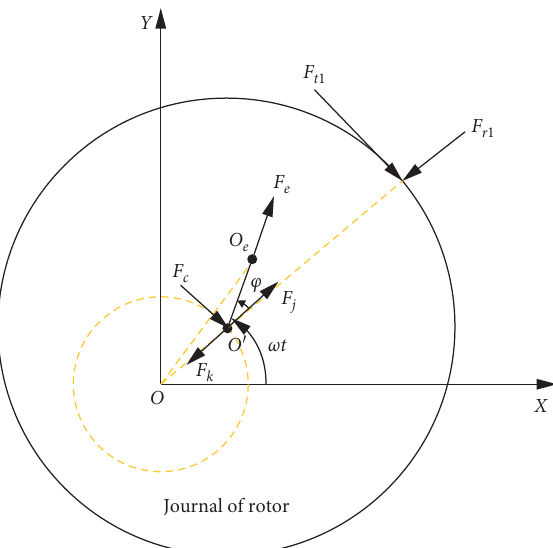
Figure 7: Force diagram for journal of rigid